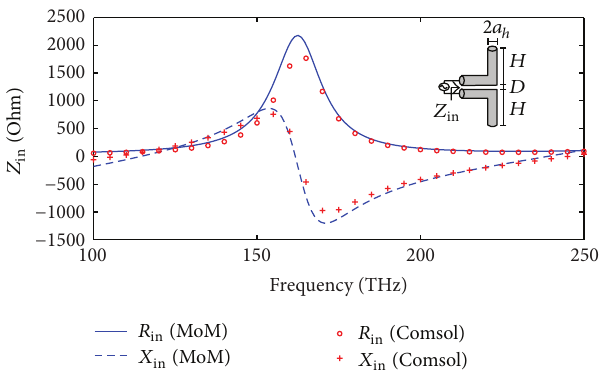
Figure 7: Input impedance of nanocircuit with 𝐿 = 100 nm, = 220 nm, 𝑎 = 𝑎 = 10 nm, and 𝐷 = 𝐻 = ℎ + 𝑎 𝐿 𝐿 ℎ 20 nm. Parameters of the MoM simulation are number of elements: 𝑁 = 32 , processing time: 15sec. Parameters of Comsol simulation are number of elements: 622327, minimum element mesh size of conductors: 0.3 nm, minimum element mesh size of spherical domain: 32.4 nm, and processing time: 5h.